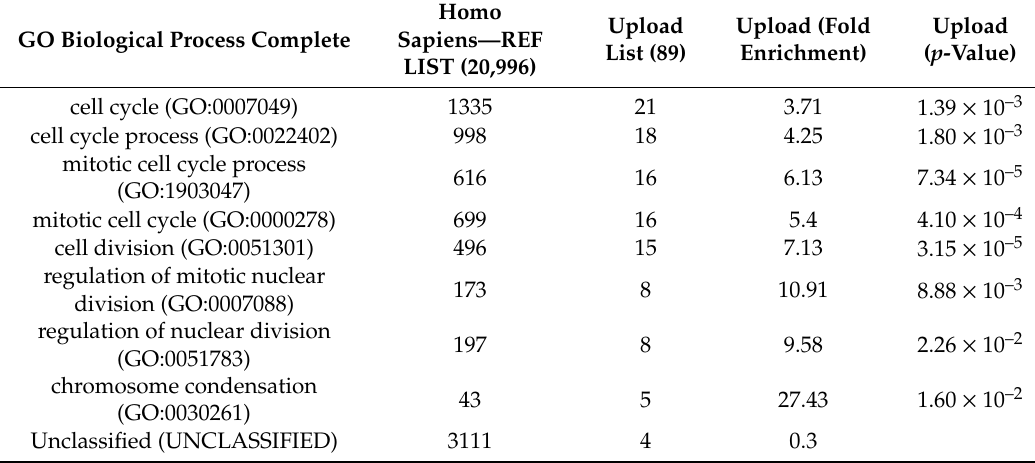
Table 9. Amigo database analysis of shortlisted genes by biological